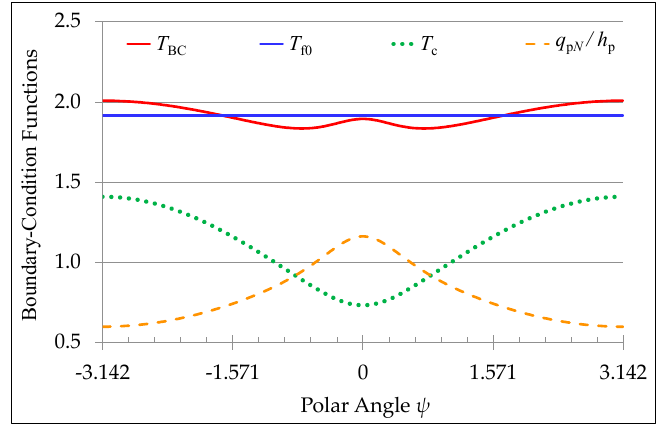
Figure 6. Boundary-condition function T BC ( ψ ) (49), and its average T f0 . The dotted curves show the boundary temperature and the radial heat flux divided by the heat transfer coefficient (50).